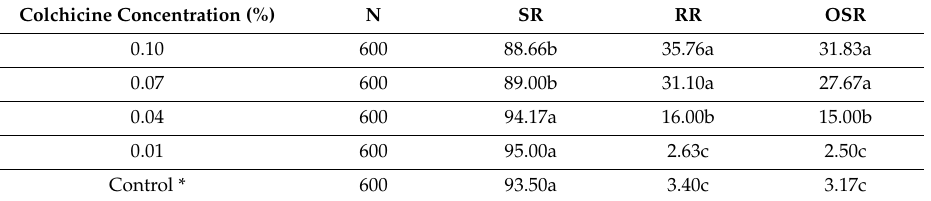
Table 6. E ff ect of di ff erent concentrations of colchicine on success rates in Method